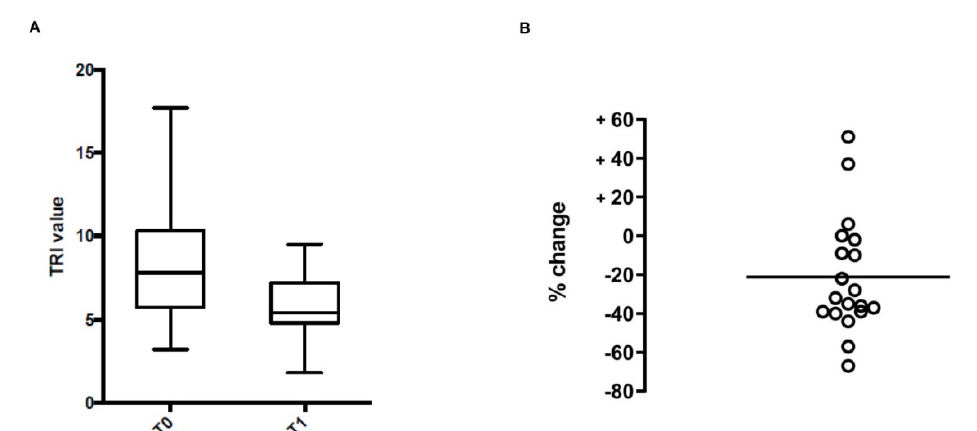
Figure 1. Kinetics of the antibody response measured before surgery (T0) and one year post-surgery (T1). A. Median and IQR values. Each rectangle spans the first quartile to the third quartile (the interquartile range = IQR). Bars indicate the median and minimum and maximum range. B. Changes in TRI. Circles represent the positive (increase) or negative (decrease) of TRI values (in percent) for each case. The bar indicates the mean